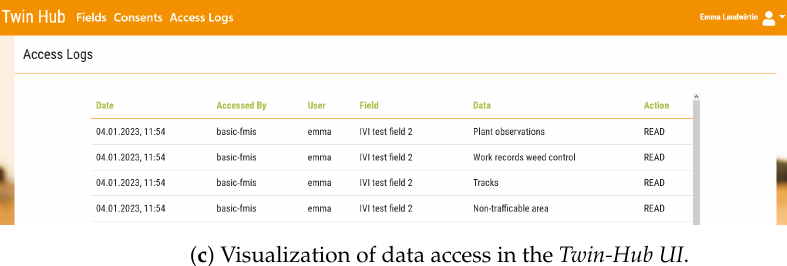
( c ) Visualization of data access in the Twin-Hub UI . Figure 13. Screenshots of the users’ journey through consent management.